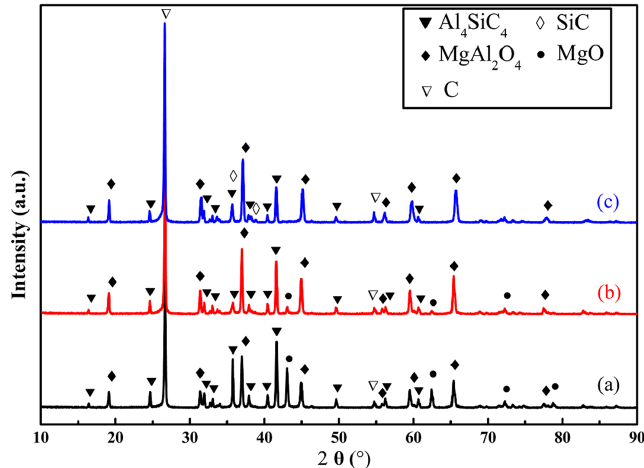
Figure 3. XRD patterns of the MgO ‐ C ‐ Al 4 SiC 4 bricks reacted at different temperature: ( a ) 1400 °C; ( b ) 1500 °C; ( c ) 1600 °C.